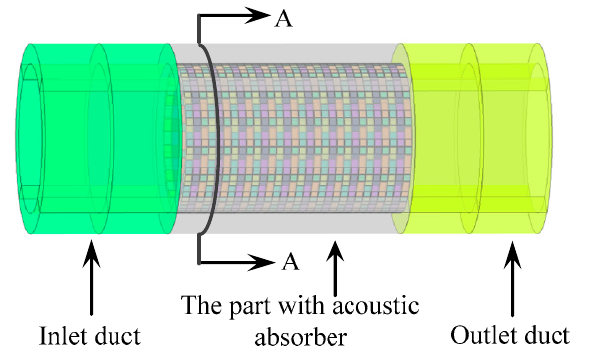
L duct = 740 mm and the total length of the cylindrical acoustic absorber is L = 330 mm.